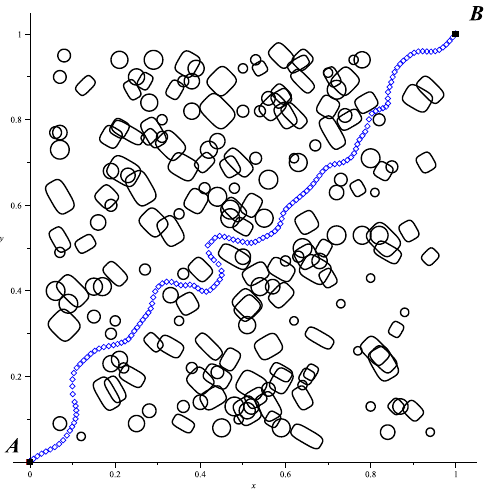
Figure 19. Example containing 200